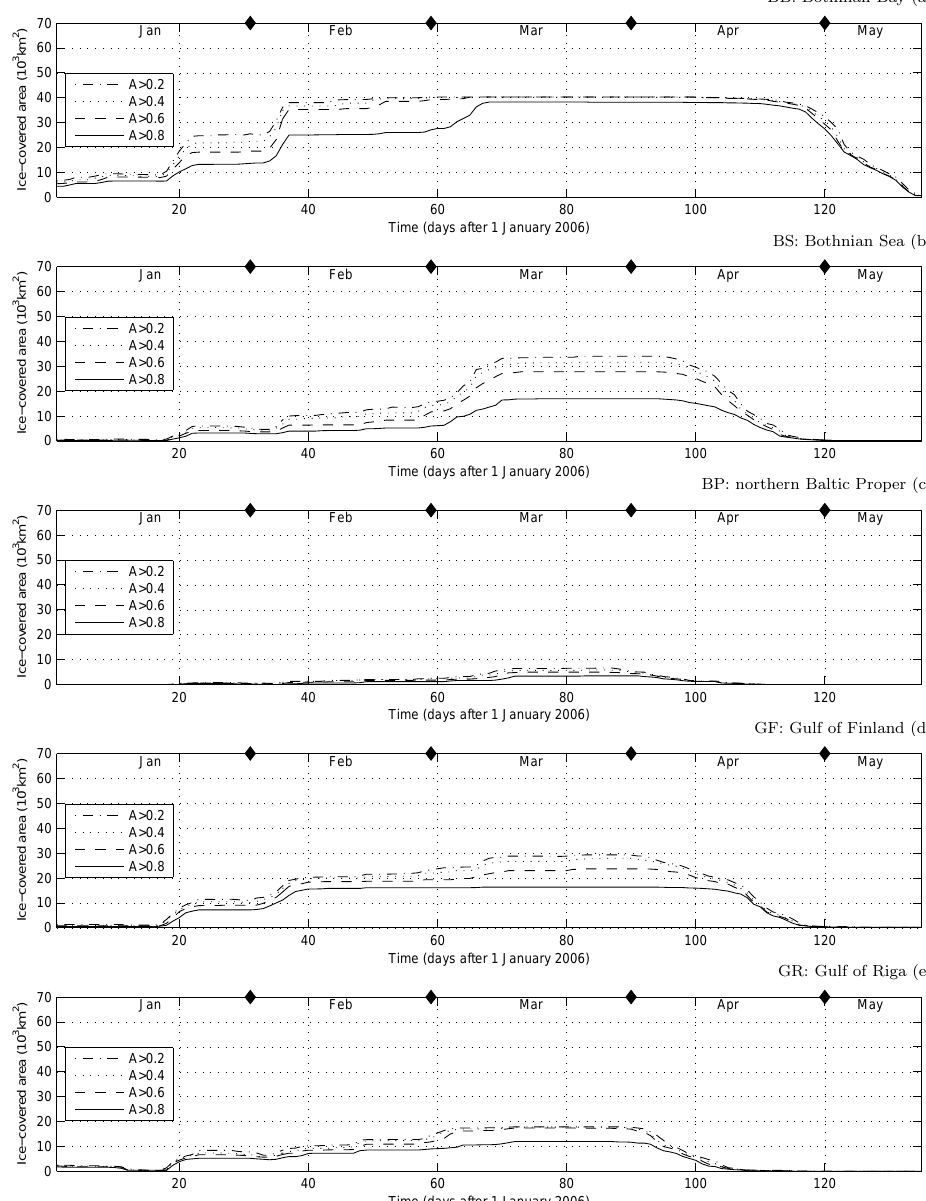
Fig. 8. As in Fig. 3, but for the sea ice concentrations simulated with the dynamic part of the sea-ice module turned